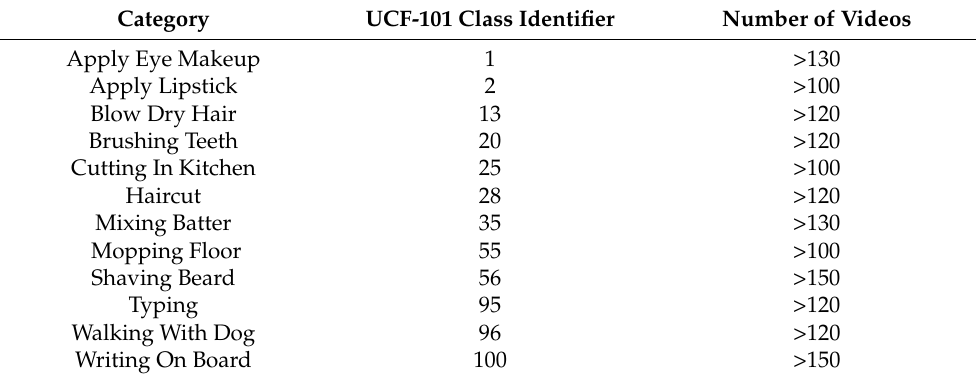
Figure 4. Visual examples of the 12 different action categories from the UCF-101 dataset used in our online action detection module. Table 2. A list detailing the subset of the action categories from the UCF-101 dataset that we have implemented in the online action detection (OAD) software module. We also report the number of videos available for